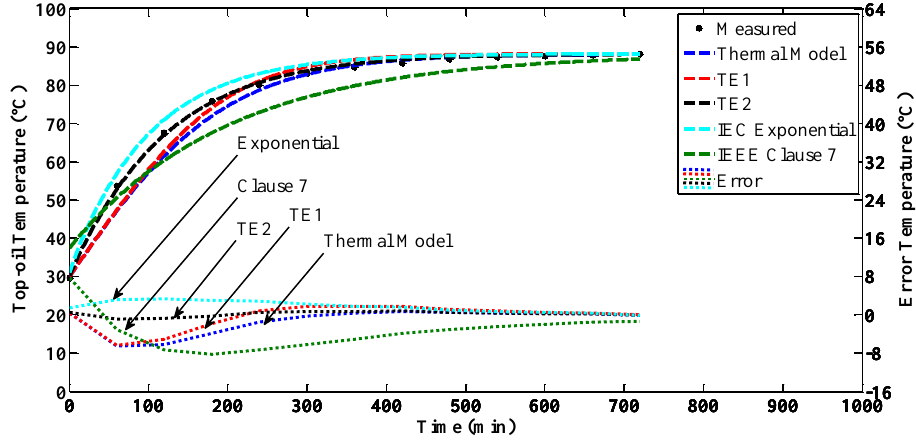
Figure 9. TOT based on different thermal models for TX3.